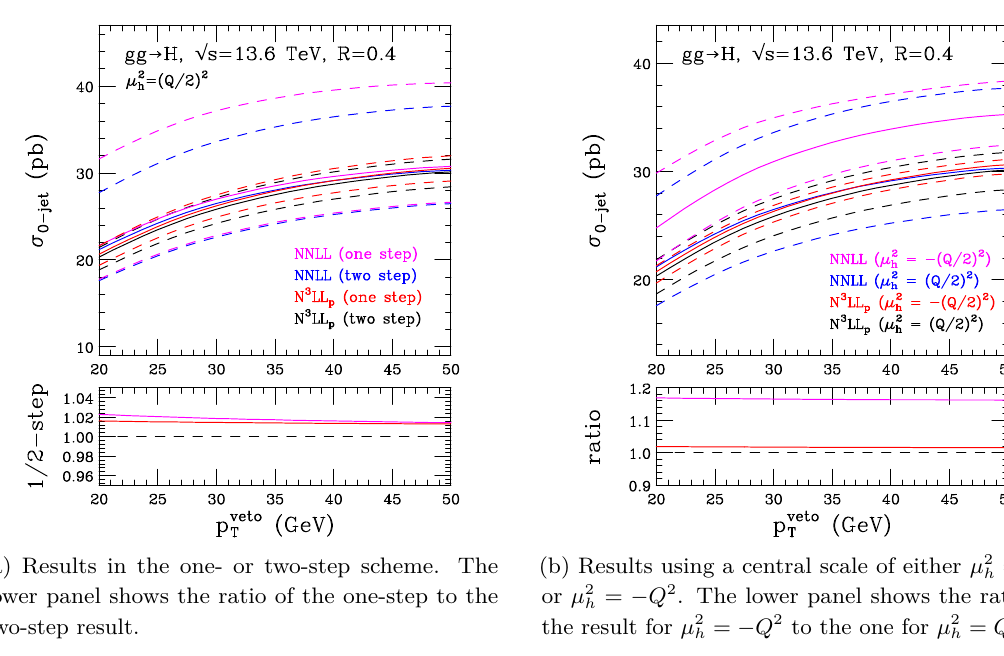
Figure 17 . Comparison of NNLL and N 3 LL p predictions for Higgs production at a function of the jet